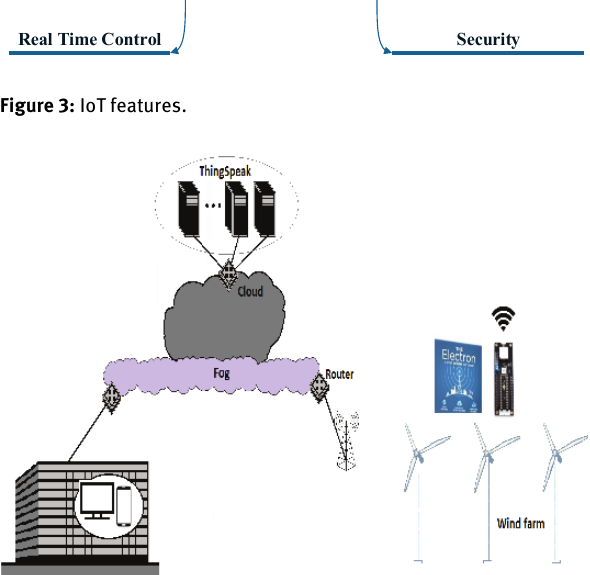
Figure 4: The proposed model to utilize IoT in wind energy genera- tion.